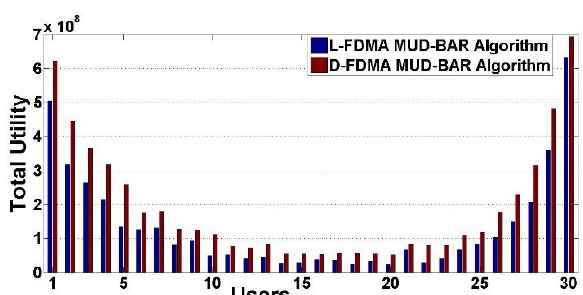
Fig. 11. Users’ utility considering L-FDMA and D-FDMA subcarrier mapping method in MUD-BAR algorithm ( δ i+1 =δ i +0.007, δ 1 =0.75 )